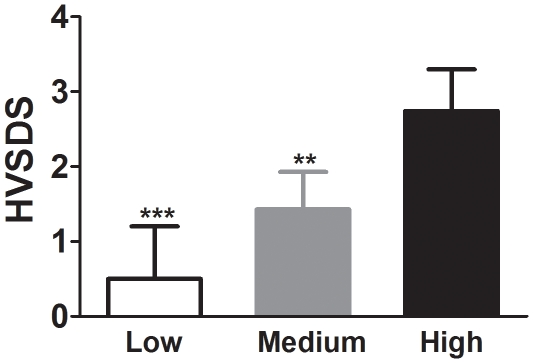
Height velocity standard deviation scores (HVSDS) over 6–8 months according to the level of compliance with GH treatment: High (n = 30) missed ≤1 dose/week, Medium (n = 51) missed >1 and <3 doses/week, and Low (n = 29) missed ≥3 doses/week.Data are mean ± SEM. **p<0.01, ***p<0.001 vs High.